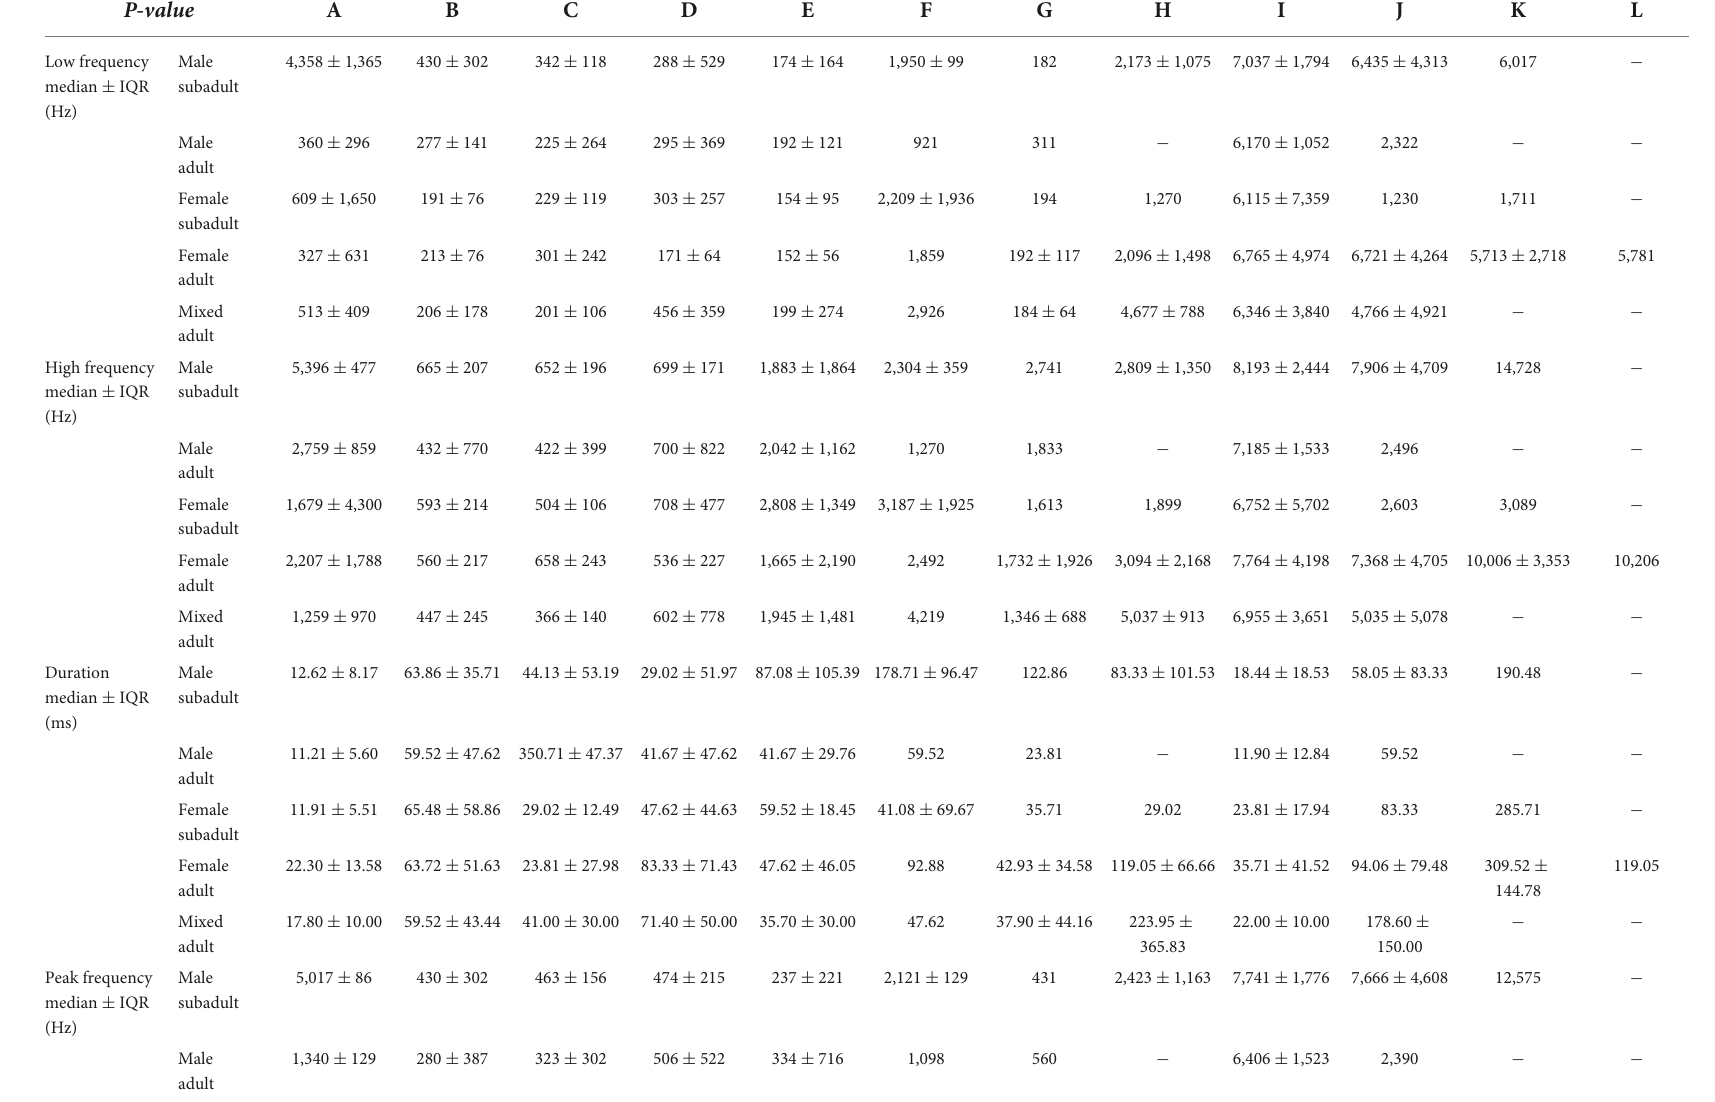
TABLE 3 Acoustic parameters of 12 call types for different age–sex